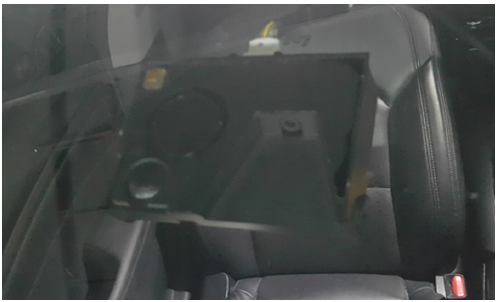
Figure 17. Integrated front camera module installed on inner